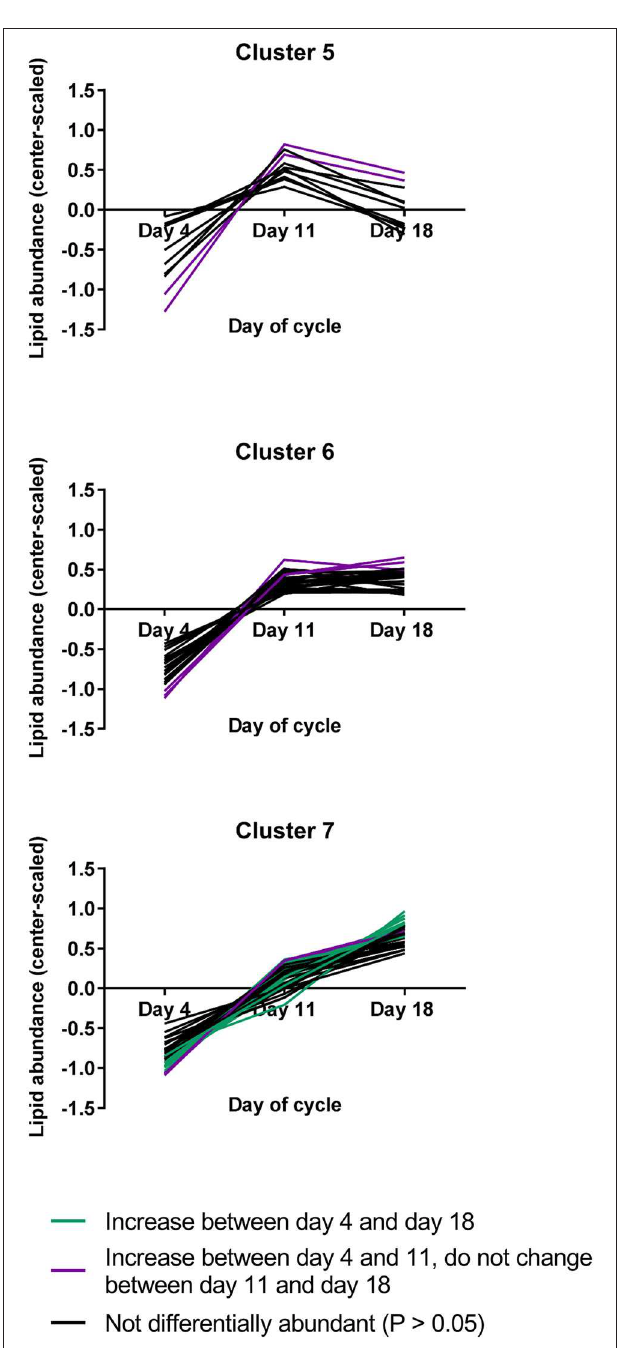
FIGURE 2 | The three lipid abundance clusters that included lipids that changed during the estrous cycle ( N = 4/group). Lipids that appeared to change but were not statistically differentially abundant are represented by black lines, while lipids that changed between days 4 and 11 are represented by purple lines and lipids that changed between days 4 and 18 are represented by turquoise lines.